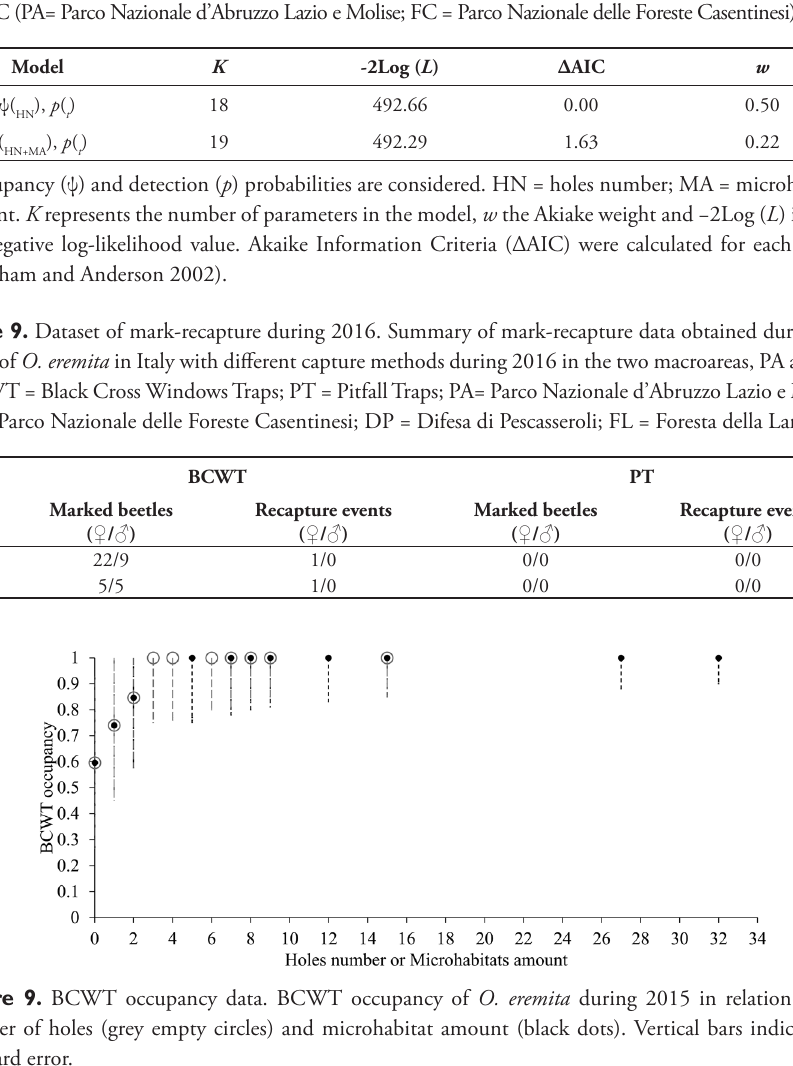
Table 8. Dataset of environmental variables. Environmental characteristics (within 2 ΔAIC from the top model) affecting the occurrence of O. eremita in BCWT. The data were obtained during 2015 in the two macroareas PA and FC (PA= Parco Nazionale d’Abruzzo Lazio e Molise; FC = Parco Nazionale delle Foreste Casentinesi).